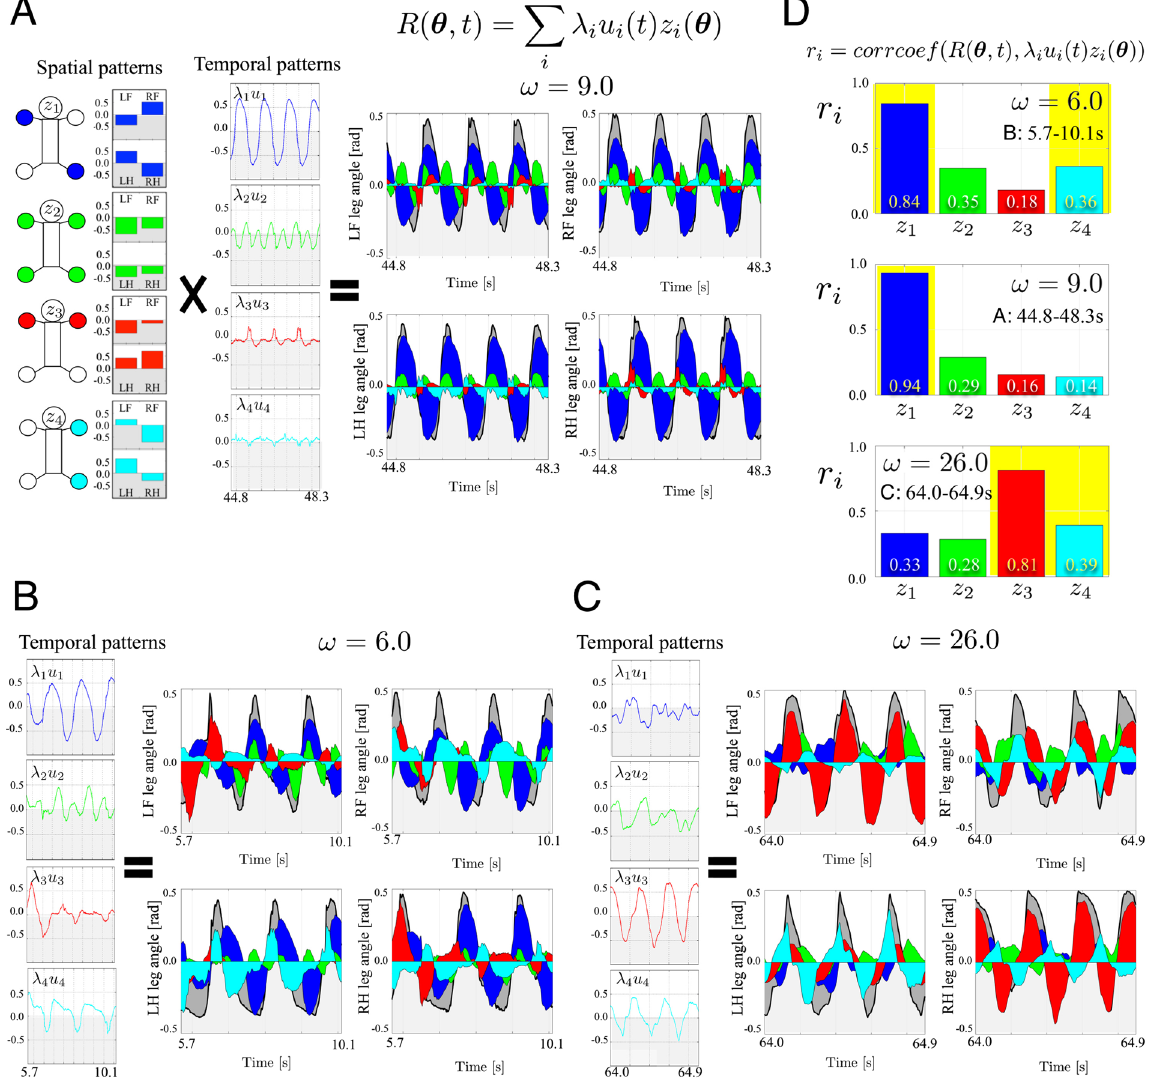
Figure 2. Interlimb coordination analysis. ( A ) Decomposition of data into time-invariant spatial patterns z i ( θ ) (left panels) and their temporal patterns λ i u i ( t ) (middle panels) using SVD on four leg angles R ( θ , t ) (right panel). This gait is a trot (b) ω = 9.0 rad/s in Fig. 1(A). The grey, blue, green, red, and cyan areas in the right figure represent the values of R ( θ , t ), λ 1 u 1 ( t ) z 1 ( θ ), λ 2 u 2 ( t ) z 2 ( θ ), λ 3 u 3 ( t ) z 3 ( θ ), and λ 4 u 4 ( t ) z 4 ( θ ), respectively. In this gait, the spatial pattern z 1 (blue, trotting) was the primary patten which sufficiently reproduced R ( θ , t ). The spatial patterns z i ( θ ) are common during gait transition experiments owing to their time-invariance. ( B ) and ( C ) depict the results for walking (a) ω = 6.0 rad/s and galloping (d) ω = 26.0 rad/s in Fig. 1(A), respectively. ( D ) Correlation analysis by calculating correlation coefficients r i between R ( θ , t ) and λ i u i ( t ) z i ( θ ). Walking ( B ) consisted primarily of the trot (blue) and pace (cyan) patterns, and galloping ( C ) consisted primarily of the bound (red) and pace (cyan) patterns. ω -dependent changes in the correlation coefficients of these patterns resulted in autonomous gait